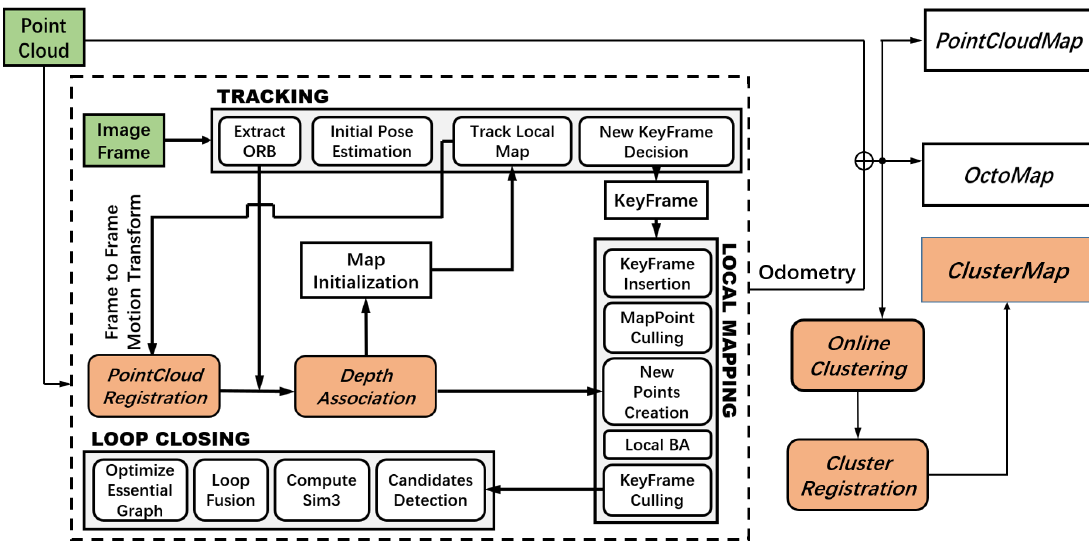
Figure 1. Pipeline of the mapping framework including the simultaneous localization and mapping (SLAM) and ClusterMap